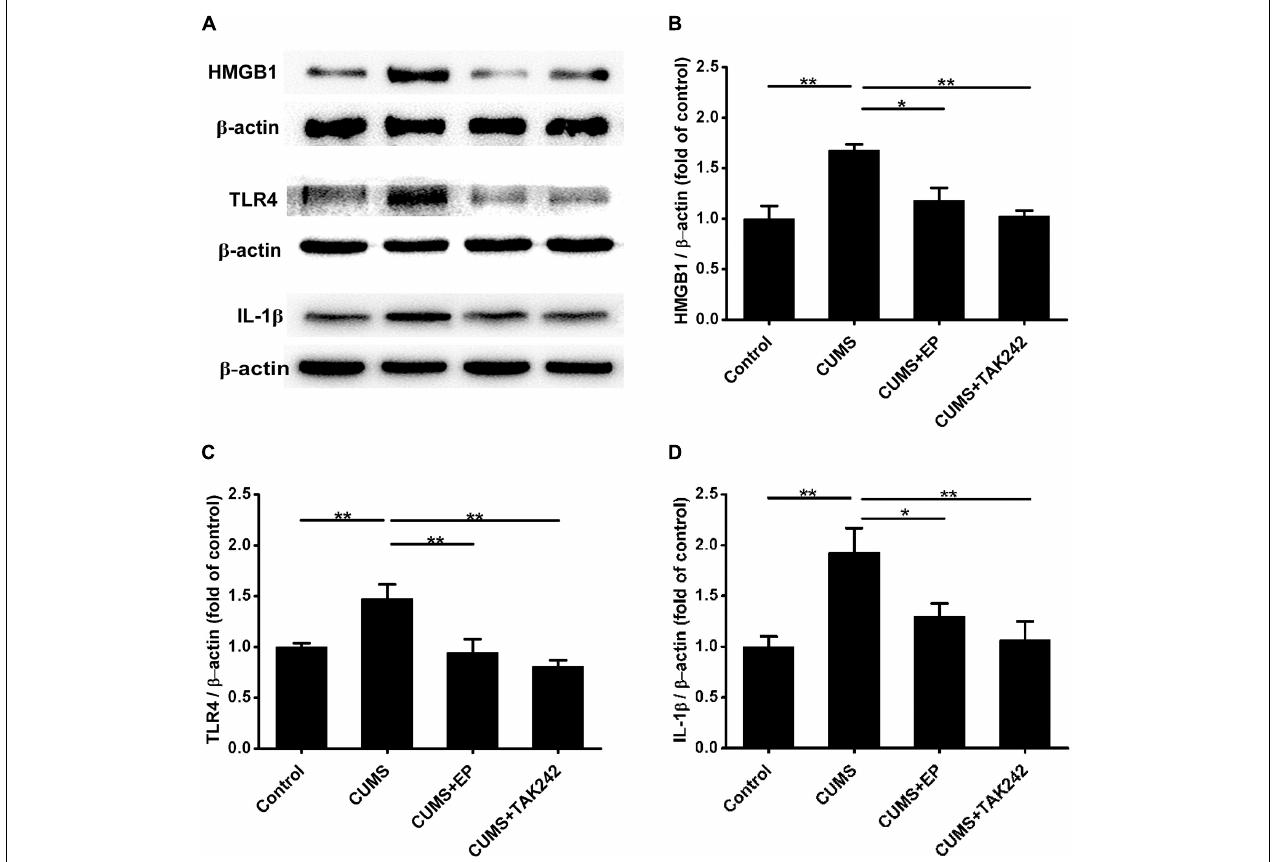
FIGURE 3 | Effect of EP and TAK-242 treatment on HMGB1, TLR4, and IL-1 β protein expressions in aorta of CUMS ApoE − / − mice. Over a 16-week period treatment, entire aorta from the aortic root to the iliac bifurcation was harvested for Western blot analysis. (A) Representative Western blots of HMGB1 (29 kDa), TLR4 (95 kDa), and IL-1 β (17 kDa). (B–D) Quantification of HMGB1, TLR4, and IL-1 β protein levels by the NIH Image J software revealed that EP and TAK-242 treatment significantly lowered those three proteins expression in the aorta of the CUMS apoE − / − mice. Data were expressed as mean ± SEM ( n = 5). Statistical analysis was performed by Student’s t -test or one-way analysis of variance. ∗ P < 0.05, ∗∗ P <